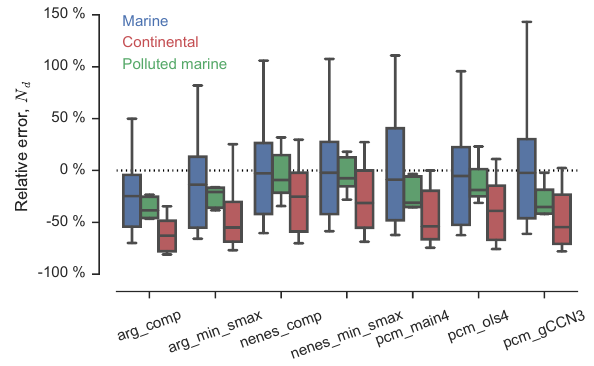
Figure 3. Distributions of relative error between observed and sim- ulated CDNC ( N d ) for each configuration of MARC, aggregated by